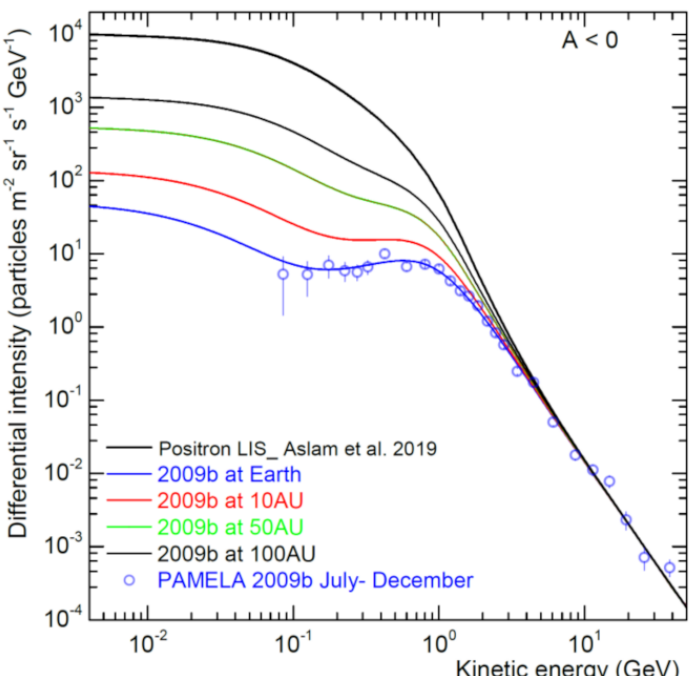
Figure 8. Computed positron spectra at Earth (blue line) compared to PAMELA data for the period July to December 2009 (A < 0 cycle), and corresponding spectra predicted for 10 AU, 50 AU and 100 AU with respect to the VLIS at 122 AU (upper black line) from